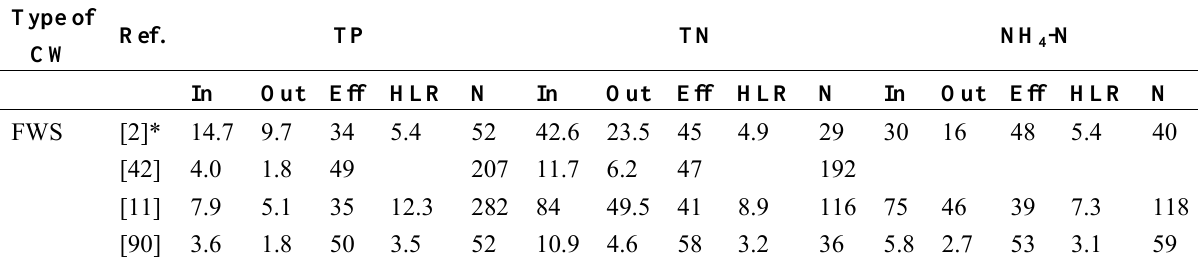
Table 5. Treatment efficiency (Eff, in %) of various types of constructed wetlands (CWs) for nitrogen and phosphorus. Inflow (In) and outflow (Out) concentrations in mg/L. HLR = hydraulic loading rate (cm/d). N = number of CWs.